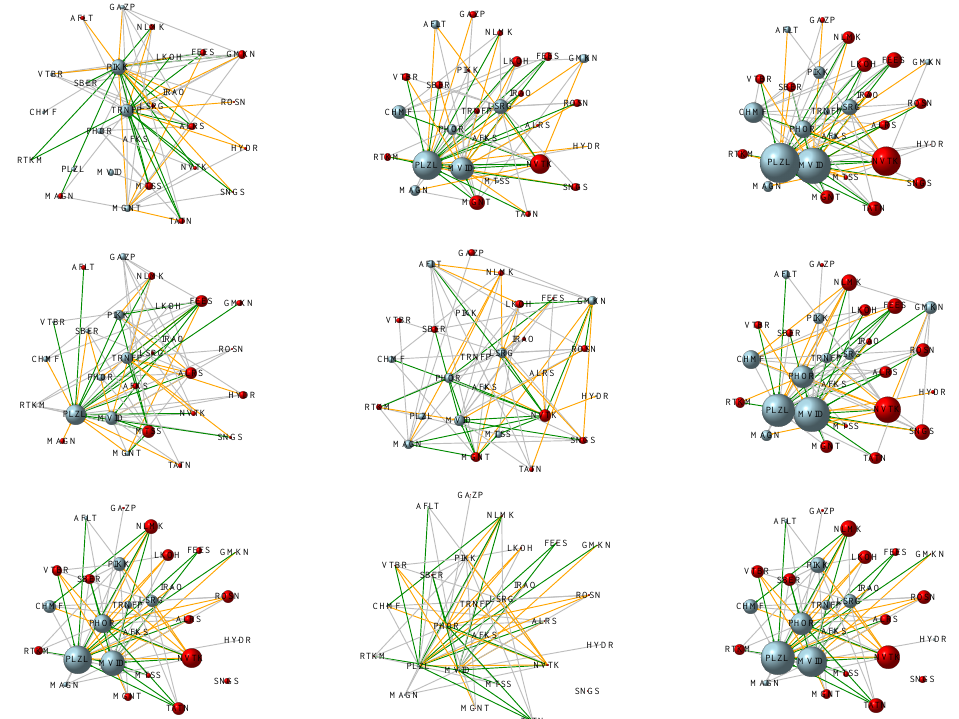
Figure 12. Net Pairwise Directional Connectedness by pandemic crisis period (from 6 January 2020 to 6 January